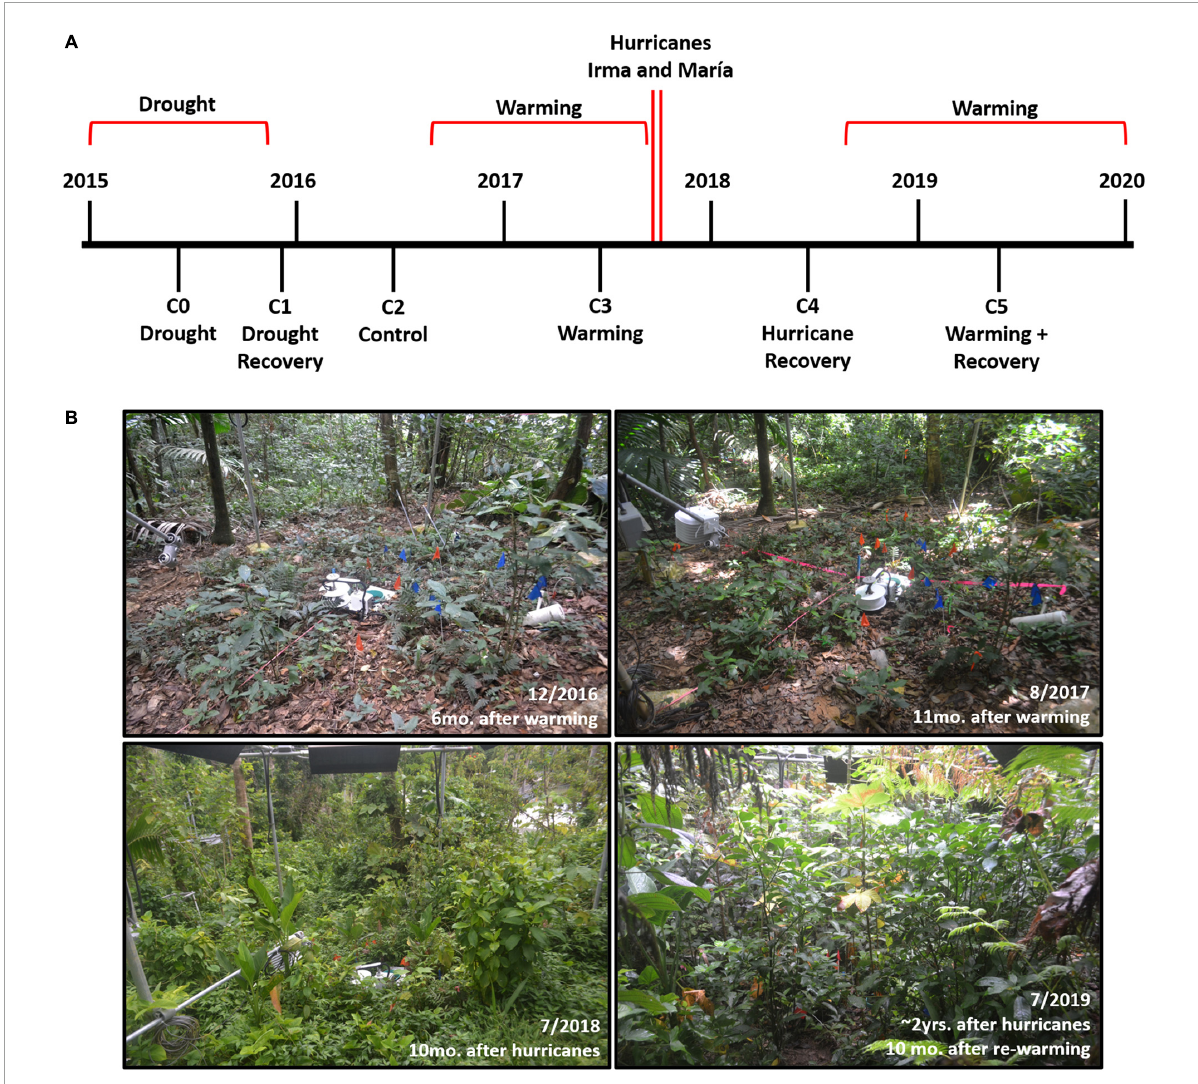
FIGURE1 (A) Timeline of disturbance events and seedling and sapling censuses (C0 = June 2015, C1 = November 2015, C2 = June 2016, C3 = June 2017, C4 = May 2018, C5 = April 2019). (B) Changes in the understory plant community observed in one of the TRACE warming plots (Plot 2)